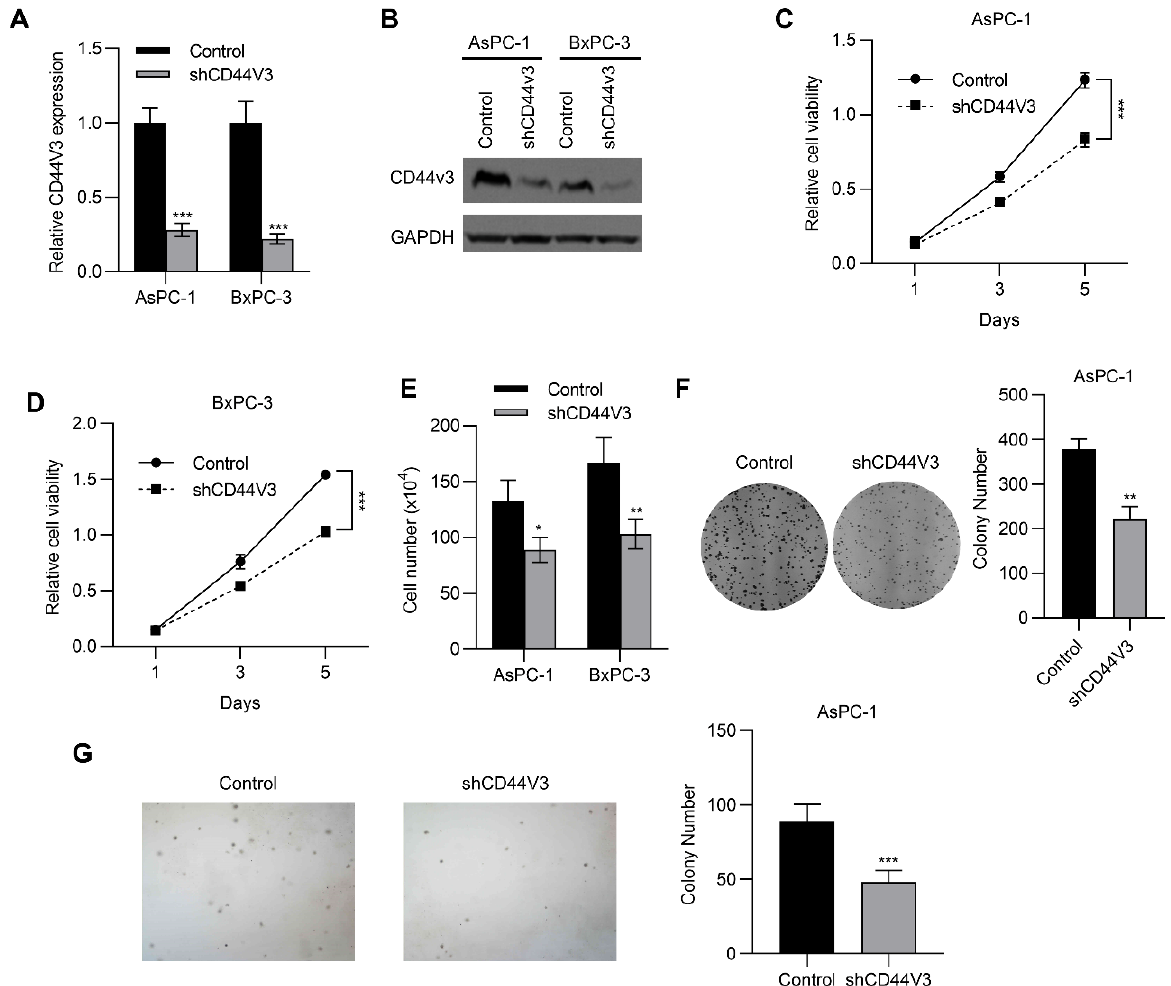
Figure 3. Downregulation of CD44V3 inhibits pancreatic cancer cell proliferation. ( A , B ) The CD44V3 levels in AsPC-1 or BxPC-3 cells transfected with CD44V3 shRNA were analyzed by qPCR ( A ) or Western blot ( B ). ( C , D ) Cell viability of AsPC-1 ( C ) or BxPC-3 ( D ) cells transfected with CD44V3 shRNA was determined by MTT assay. ( E ) A cell count assay was used to determine the viability of AsPC-1 or BxPC-3 cells transfected with CD44V3 shRNA. ( F ) The foci formation assay was used to determine the viability of AsPC-1 cells transfected with CD44V3 shRNA. ( G ) The cell viability of AsPC-1 cells transfected with CD44V3 shRNA was determined by a soft agar assay. The data are presented as mean ± S.D. * p < 0.05; ** p < 0.01; *** p <